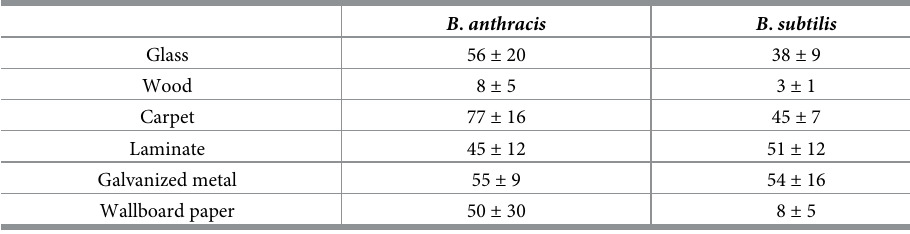
Table 5. Average percent recovery ± SD of each microorganism from positive controls.